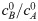
Numerical Simulation: Test of reciprocal relationship for different bulk concentrations (left side of panel) and different initial conditions (right side of the panel).A) The quotient of reciprocal trajectories cB(t)/cA(t) for different bulk concentrations divided by their bulk concentration ratio (cB0/cA0 = 0.1,1, and 10. cA0 was kept constant at 0.1M; only cBb was changed). Initial conditions: [cA(0),cB(0)]1 = [0.2 M, 0] for cB(t) and [cA(0),cB(0)]2 = [0,0.2 M] for cA(t); cB(t) from condition 1 is divided by cA(t) from condition 2 to get the quotient. B) Phase space trajectories corresponding to results in panel A. The initial condition for trajectories 1,2, and 3 is [cA(0),cB(0)]1 = [0,0.2 M]. For trajectories 1’, 2’, and 3’ the initial condition is [cA(0),cB(0)]2 = [0.2 M, 0]. The bulk concentration ratios: for (1 and 1’), (2 and 2’) and (3 and 3’) are 0.1 M, 1 M, and 10 M, respectively. C) Ratio cB(t)/cA(t) for different initial conditions in the form [cA(0),cB(0)] = [x,0] for determining cB(t) and [0,x] for cA(t) (x = 0.002 M, 0.02 M, 0.2 M, 2 M, 20 M). The bulk ratio was kept constant at cB0/cA0 = 2. D) Phase state trajectories corresponding to results in panel C. The initial conditions for trajectories 1, 2, 3, 4, and 5 follow the same form as panel C with [cA(0),cB(0)]1 = [0,x] where x = 0.002 M, 0.02 M, 0.2 M, 2 M, 20 M respectively. For trajectories 1’, 2’, 3’, 4’, and 5’ the initial conditions are [cA(0),cB(0)]1 = [x,0] where x = 0.002 M, 0.02 M, 0.2 M, 2 M, 20 M respectively.